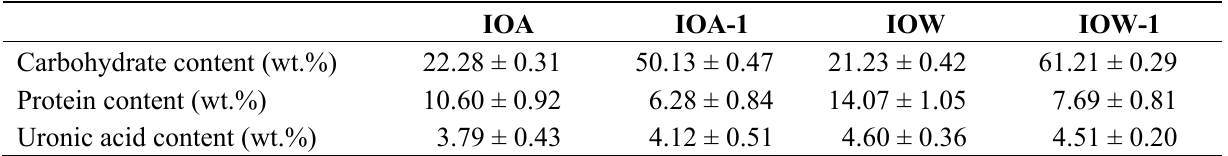
Table 1. Major chemical content of the alkaline and water extracts.